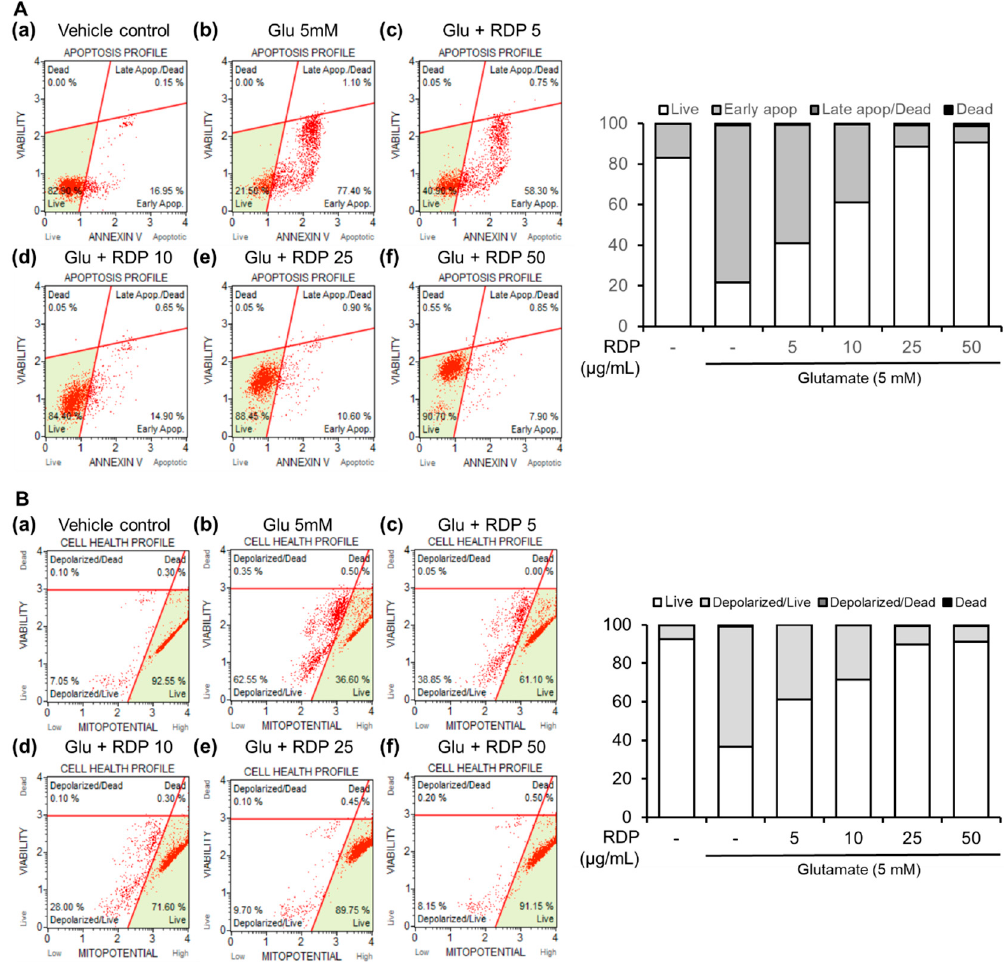
Figure 4. Effect of ethyl acetate extract of Ribes diacanthum Pall (RDP) on apoptotic bodies and mitochondrial membrane potential in HT-22 cells by flow cytometry. ( A ) Apoptotic bodies and ( B ) mitochondrial membrane potential in ( a ) vehicle control; ( b ) glutamate 5 mM; ( c ) glutamate 5 mM + RDP 50 μ g/mL; ( d ) glutamate 5 mM + RDP 10 μ g/mL; ( e ) glutamate 5 mM + RDP 25 μ g/mL, and ( f ) glutamate 5 mM + RDP 5 μ g/mL. HT-22 cells were seeded in 60-mm dishes for 24 h and then treated with or without RDP (0–50 μ g/mL) for 30 min before glutamate challenge (5 mM). After 12 h, the apoptotic bodies and mitochondrial membrane potential in the harvested cells were analyzed by flow cytometry-indicated absence.